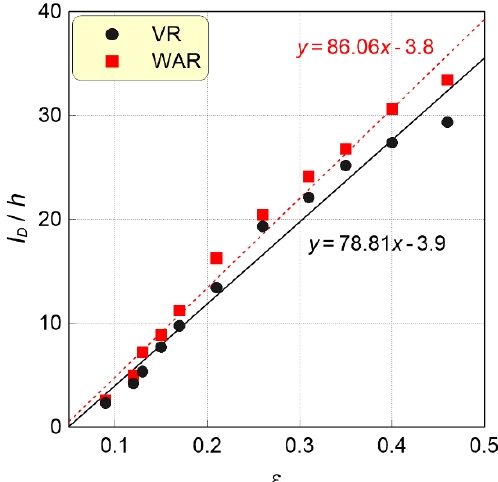
Figure 24. Spatial distributions of maximum water surface elevations around the VR and WAR.